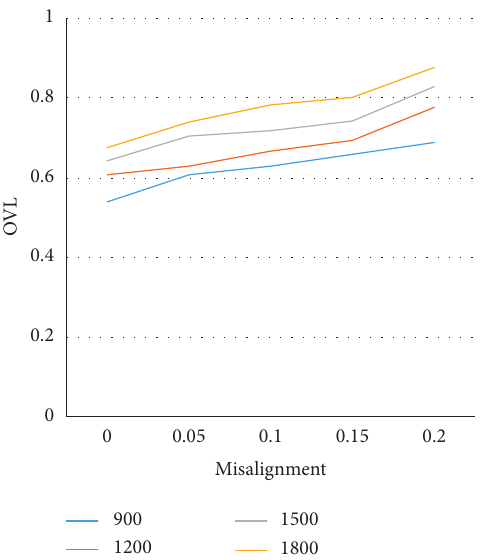
Figure 6: OVL v/s misalignment at different speeds. Table 1: Input parameters for pilot